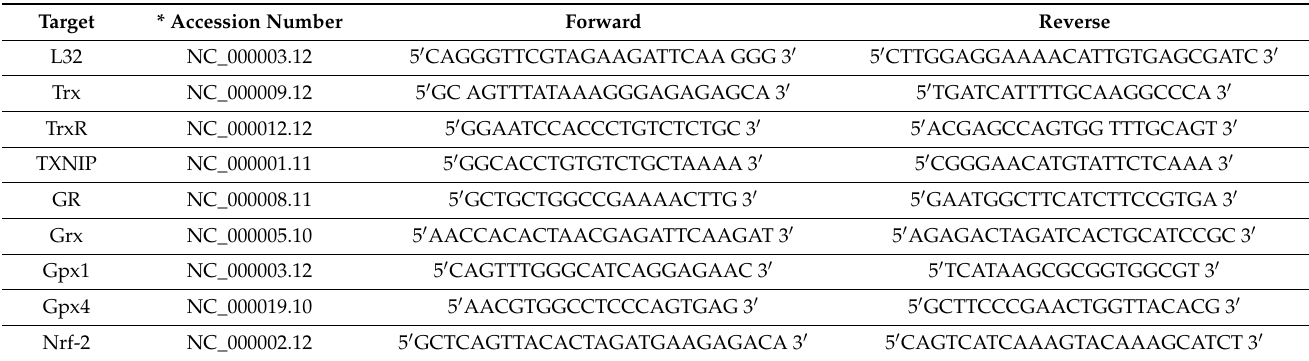
Table 1. List of